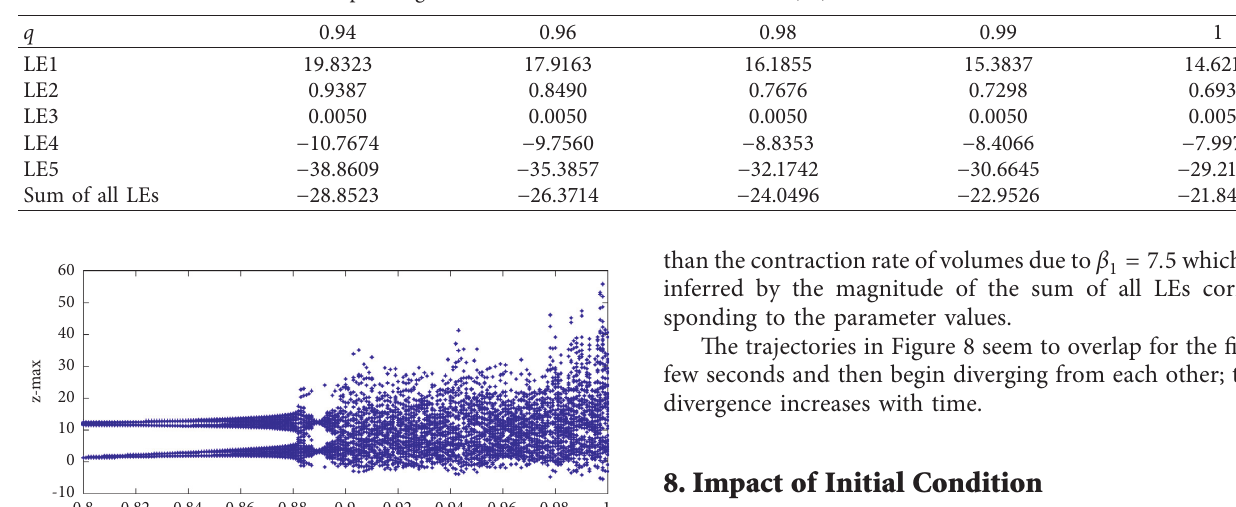
Table 1: LEs corresponding to different fractional orders of model (25) for a simulation time of 300s.